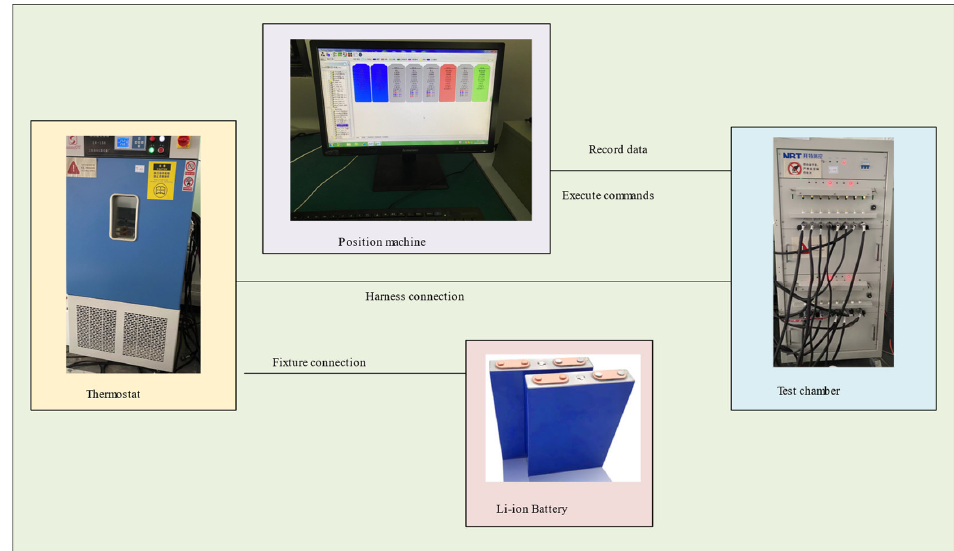
Figure 3. Ba tt ery test system. Figure 3. Battery test system. Table 2. Ba tt ery parameters.